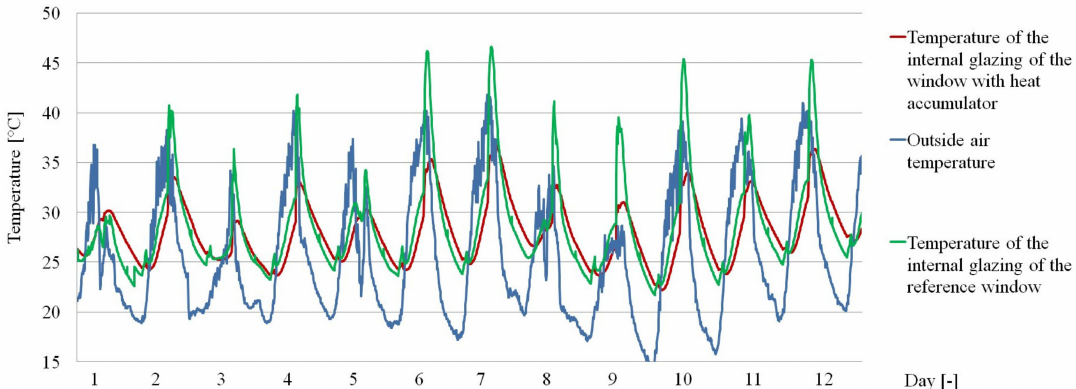
Figure 9. Temperature values recorded on the internal glazing of the window with the heat accumulator and the refer- ence window.